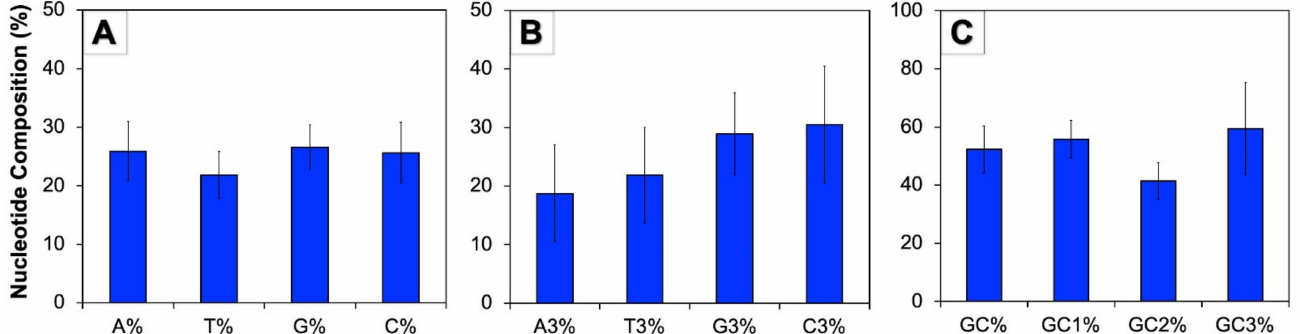
Figure 1. Nucleotide composition of coding sequences of human autophagy genes. ( A ): Average composition of individual bases among 224 human autophagy genes; ( B ): A, T, G, and C frequency at the third position of the codons; ( C ): Distribution of overall GC content and GC content at the first, second, and third codon